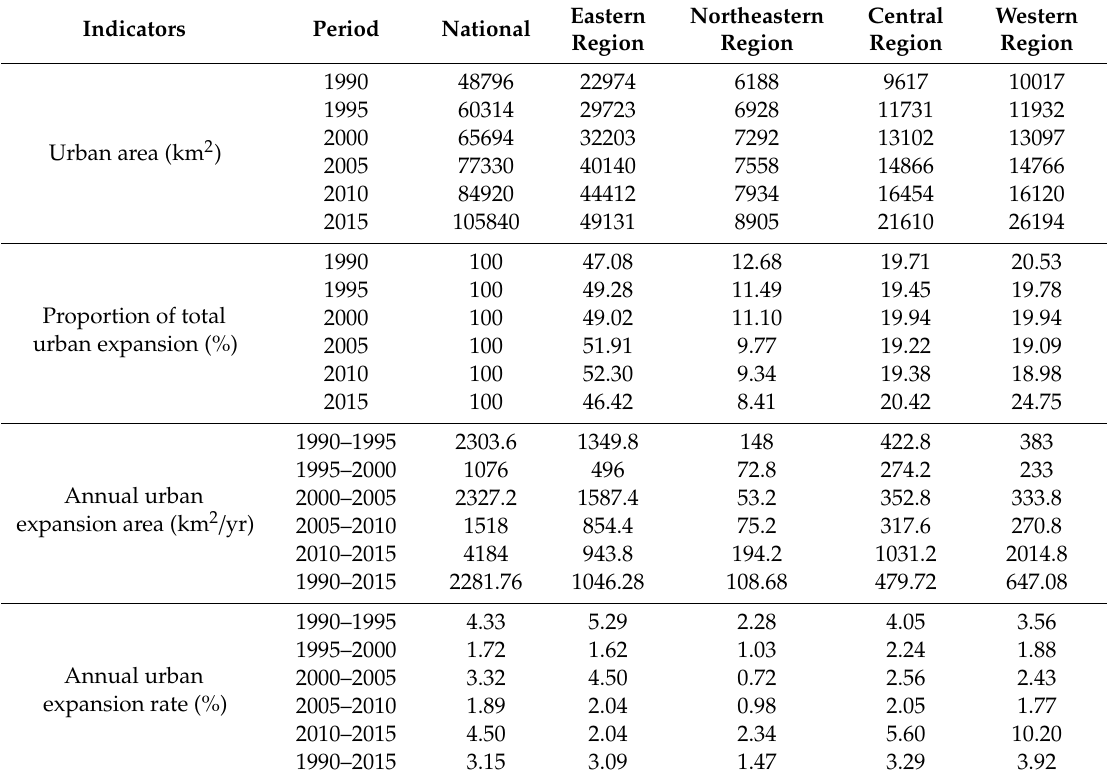
Table 2. Urban area and urban expansion in China during